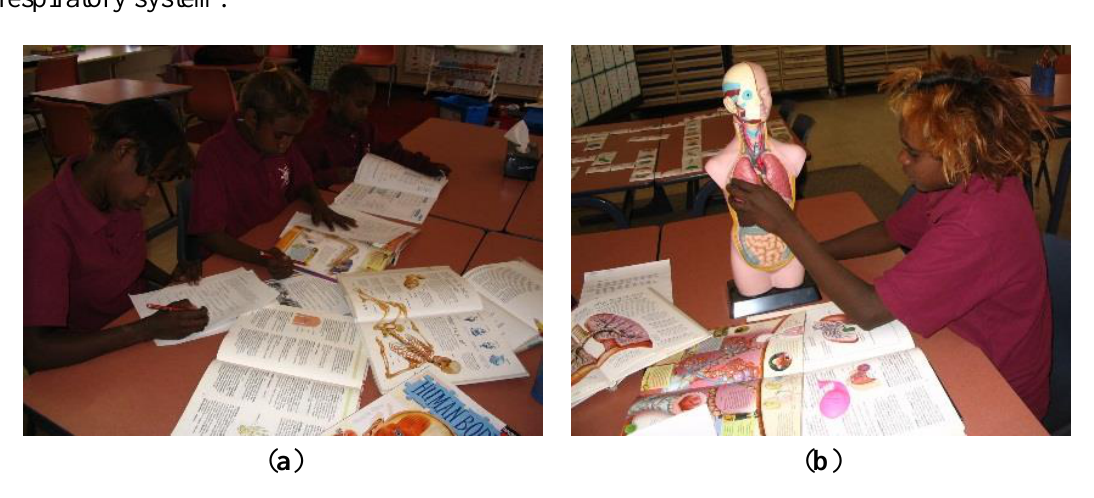
Figure 4. ( a ) English/science: Researching the human body; ( b ) Science: Researching the respiratory system.